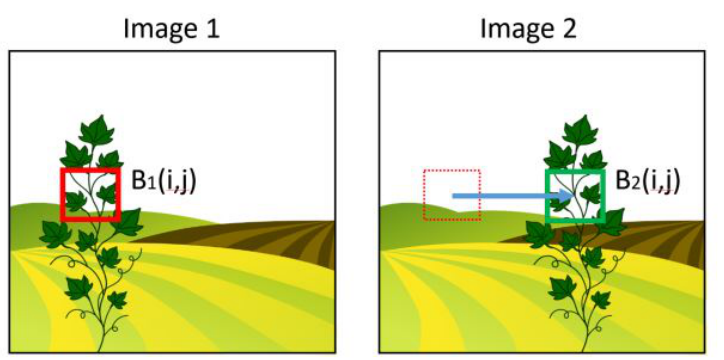
Figure 11. Classical block matching